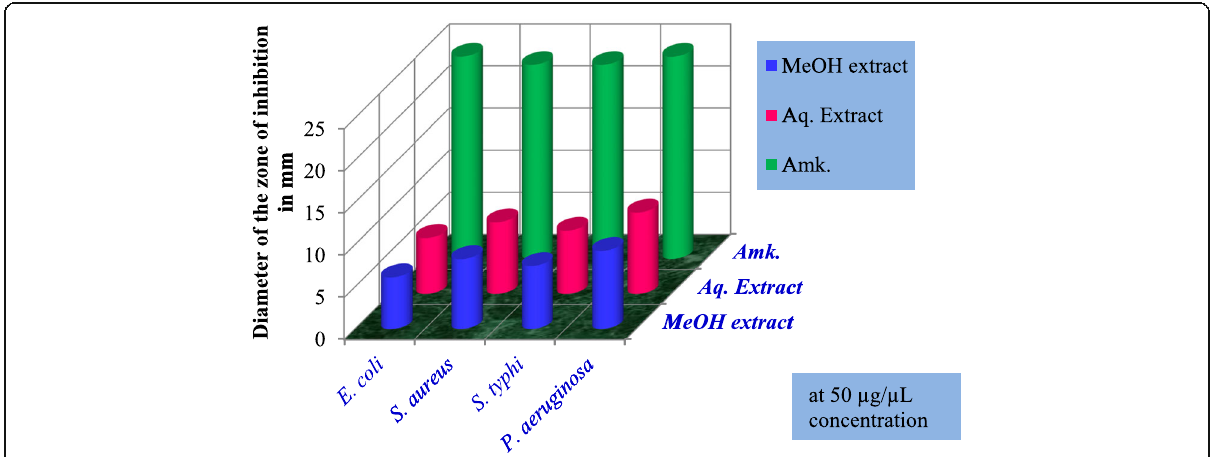
Fig. 4 Bar graph of antibacterial sensitivity of leaf extract at 50 μ g/ μ L